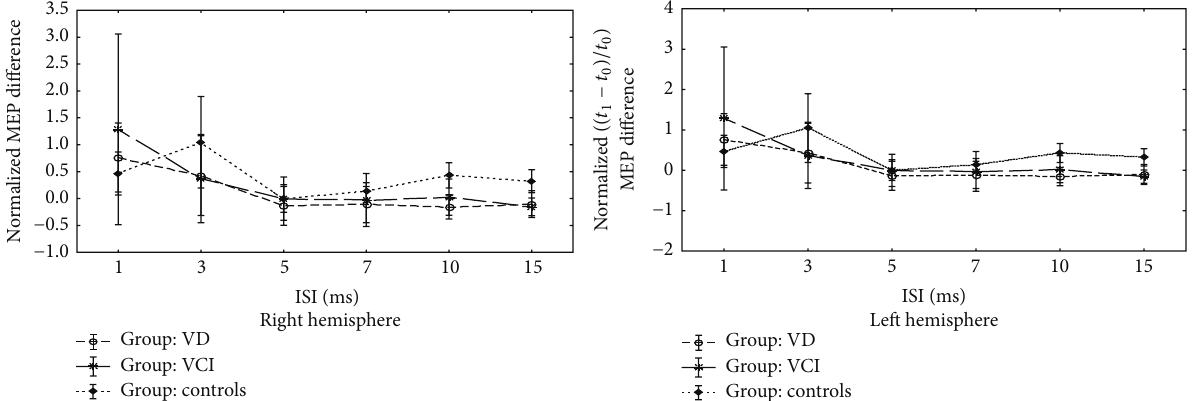
Figure 2: Comparison of the time course of intracortical excitability of patients and controls between baseline ( 𝑡 0 ) and follow-up ( 𝑡 1 ). Normalized MEP difference is computed as ( 𝑡 1 − 𝑡 0 )/𝑡 0 . The comparison over time of the paired-pulse TMS curves between patients and controls did not show significant differences in terms of intracortical inhibition and intracortical facilitation between the three groups. y -axis shows the normalized MEP difference at baseline ( 𝑡 0 ) and at follow-up ( 𝑡 1 ) (computed as the value at time 𝑡 1 minus the one at time 𝑡 0 divided by 𝑡 0 ). MEP, motor evoked potential; ISI, interstimulus interval; VD, patients with vascular depression; VCI, patients with vascular cognitive impairment-no